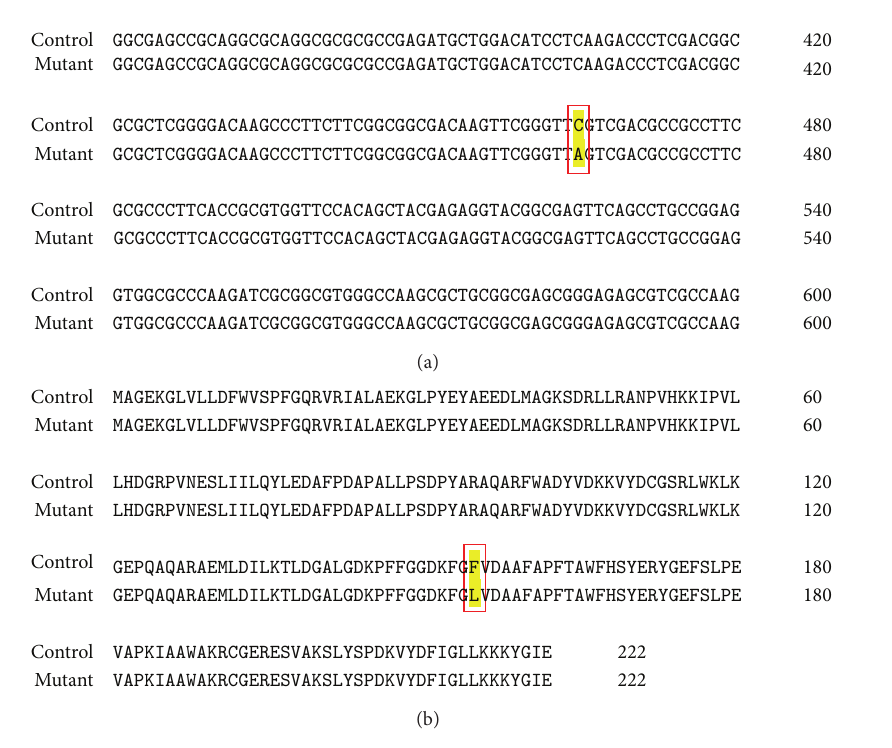
Figure 2: Partial cDNA (a) and complete protein sequence (b) alignments for Glutathione transferase (EU584497) genes. Highlighted in yellow, SNPs mutation in genomic sequence and amino acid substitution.